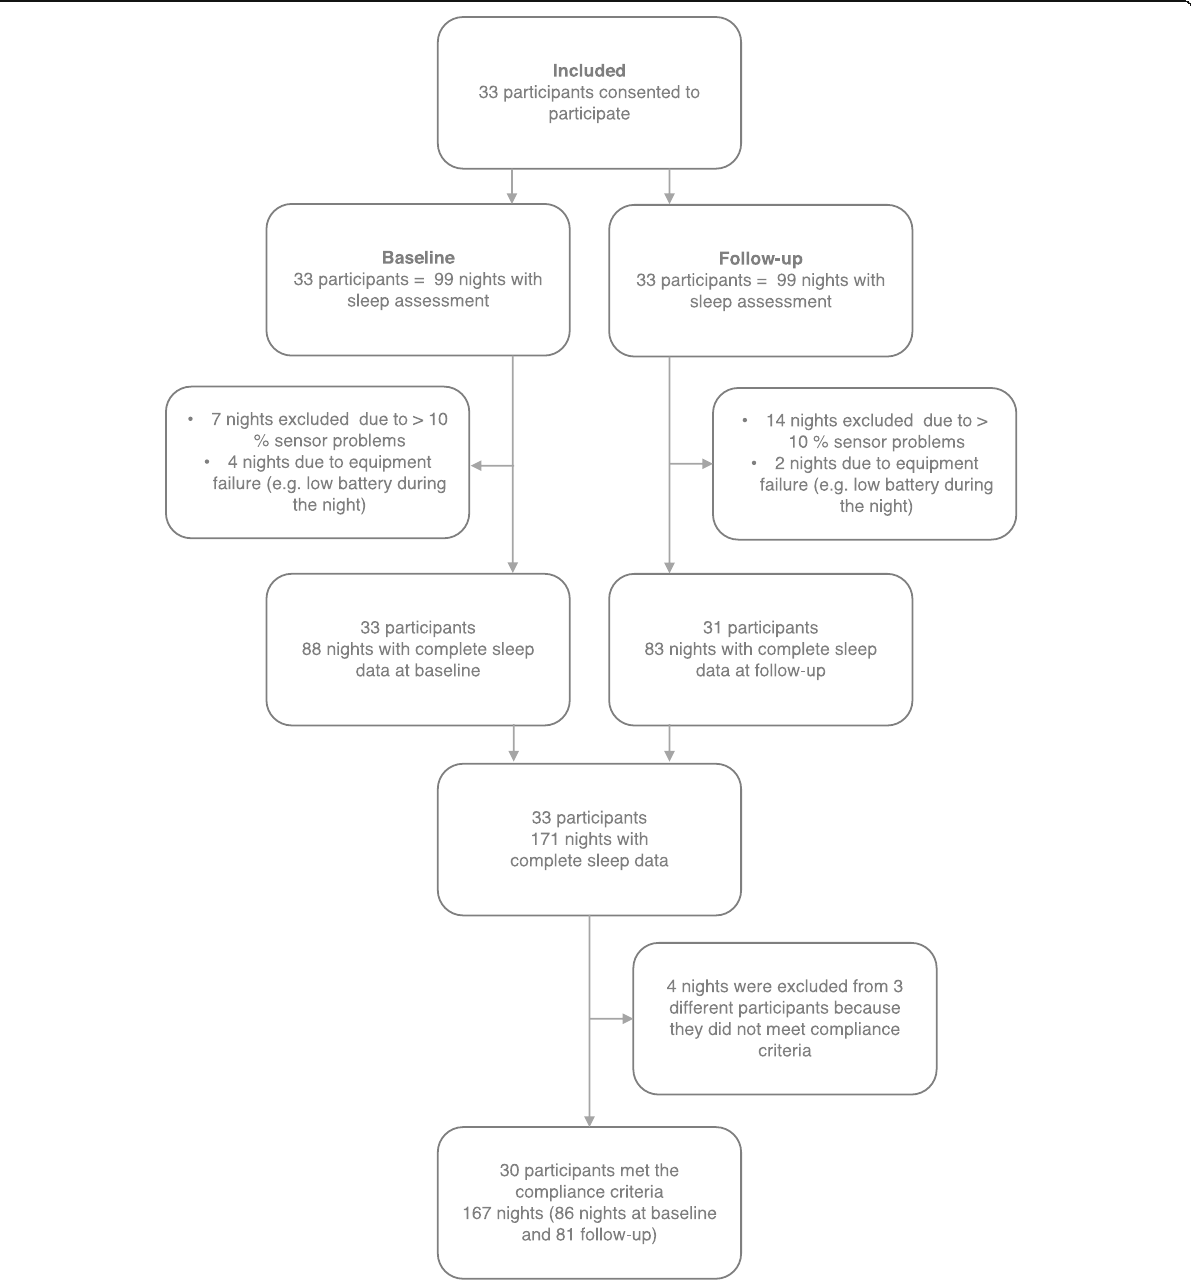
Fig. 3 Flow of participants from inclusion to compliant participants. The figure shows the flow of participants from inclusion to compliant participants. The number of nights with complete sleep data is also shown at each stage